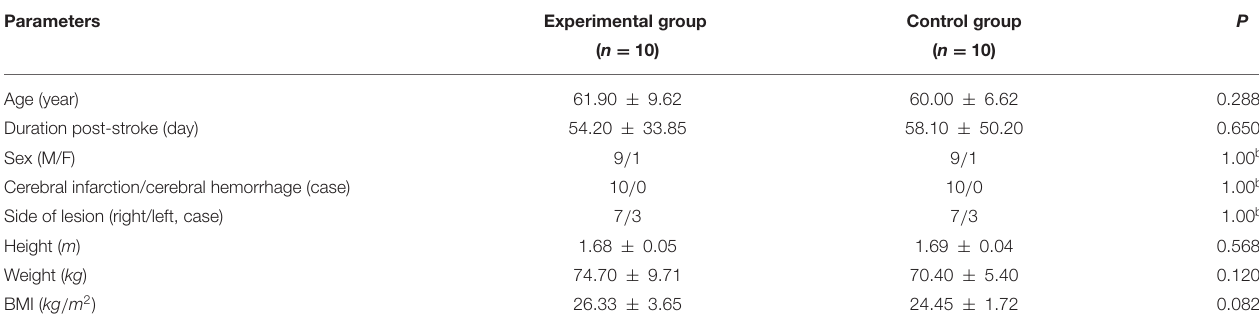
TABLE 1 | Baseline Characteristics of the Subjects a .